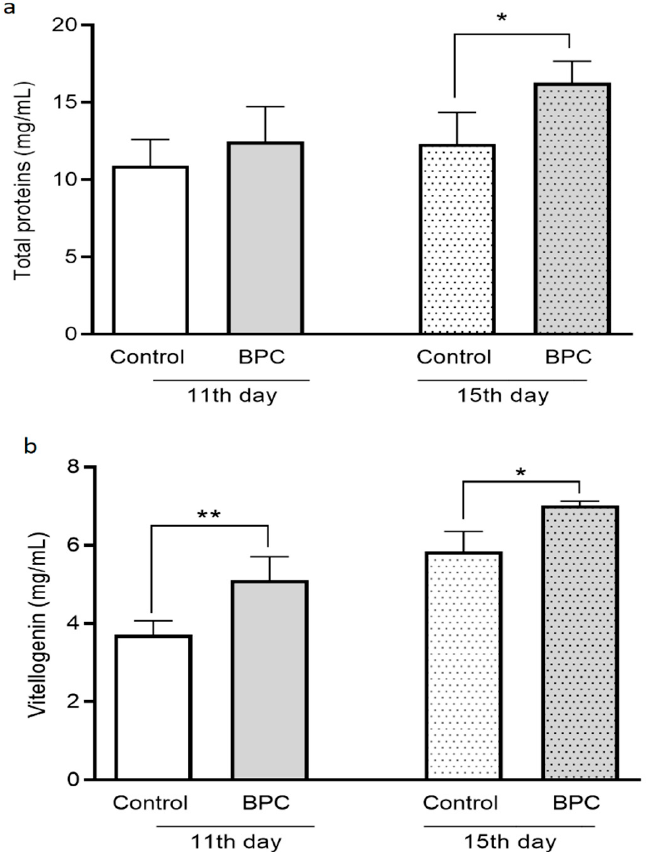
Figure 6. Concentrations of total proteins ( a ) and vitellogenin ( b ) in adult honeybee hemolymph sampled on the 11th and 15th day of the experiment under laboratory-controlled conditions for the experimental BPC and control groups. Asterisks indicate statistically significant differences: BPC vs. control, total proteins * p < 0.05, vitellogenin ** p < 0.0001, * p < 0.05; mean ± SD.